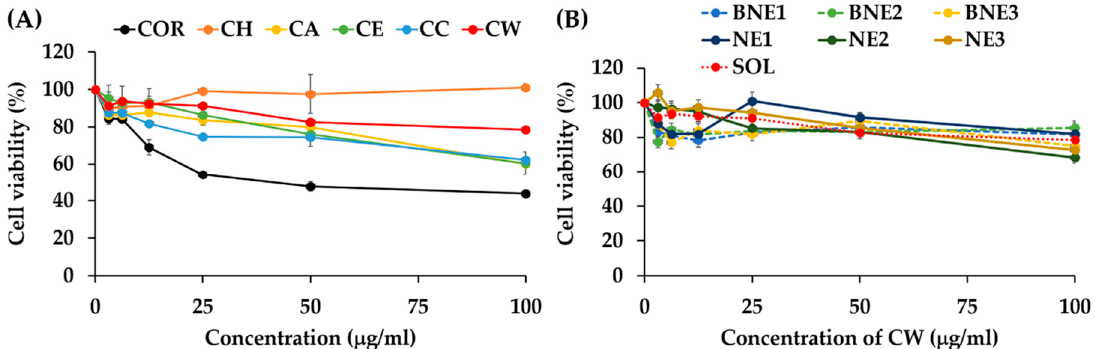
Figure 14. Concentration-viability curve of cordycepin (COR) and C. militaris extracts, including hexane extract (CH), ethyl acetate (CA), ethanolic extract (CE), crude ethanolic extract (CC) and water extract (CW) ( A ) and nanoemulsions containing CW (NE1, NE2, and NE3), their blank nanoemulsions (BNE1, BNE2, and BNE3), and CW solution (SOL) on HaCaT keratinocyte cell line ( B ).